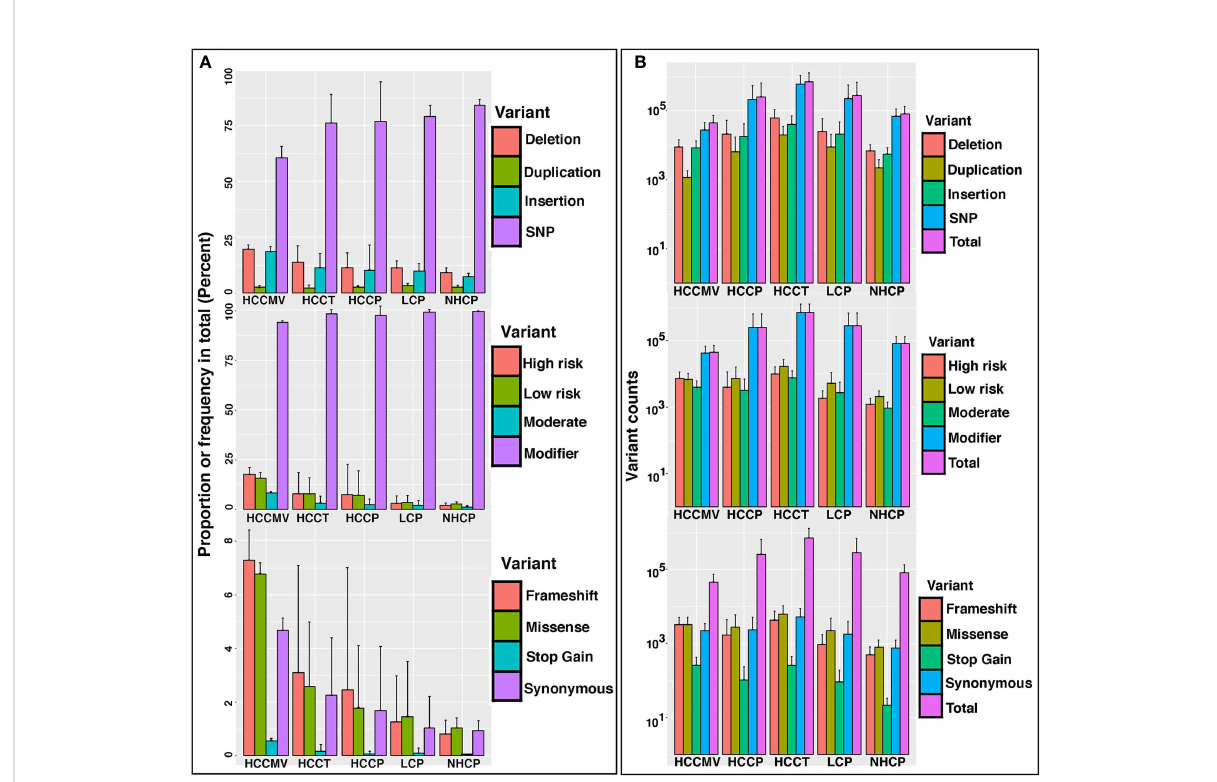
FIGURE 1 Diversity and pro fi les of circulating mRNA variants detected in the circulation, circulating extracellular vesicles and tumors of HCC patients. (A) . Bar charts representing proportion or frequency of occurrence (% age) in patient and control specimens; HCCMV, HCC circulating microvesicles (n=6); HCCT, HCC tumors (n=6); HCCP, HCC plasma (n=14); LC, liver cirrhosis plasma (n=8); NHCP, healthy control plasma (n=6). Separate bar graphs are shown to represent pro fi les by type, impact, and functional class of variants. Error bars represent the variation within samples. (B) . Bar graphs representing the total number and number of variant counts corresponding to different categories in the same sample subsets as 1A. The average number of variants per sample in RNA collected from different sources of subjects represented by the height of the bar, while the error bar showing the standard deviation within the group. Variant calling used a depth >=5 and QUAL value >=20. The ‘ QUAL ’ value for each called SNP is calculated as -log10(p) where p is the p value yielded from the statistical test carried out by ExactSNP. Therefore, a ‘ QUAL ’ value of 20 corresponds to a p value of 10^-20, which is extremely